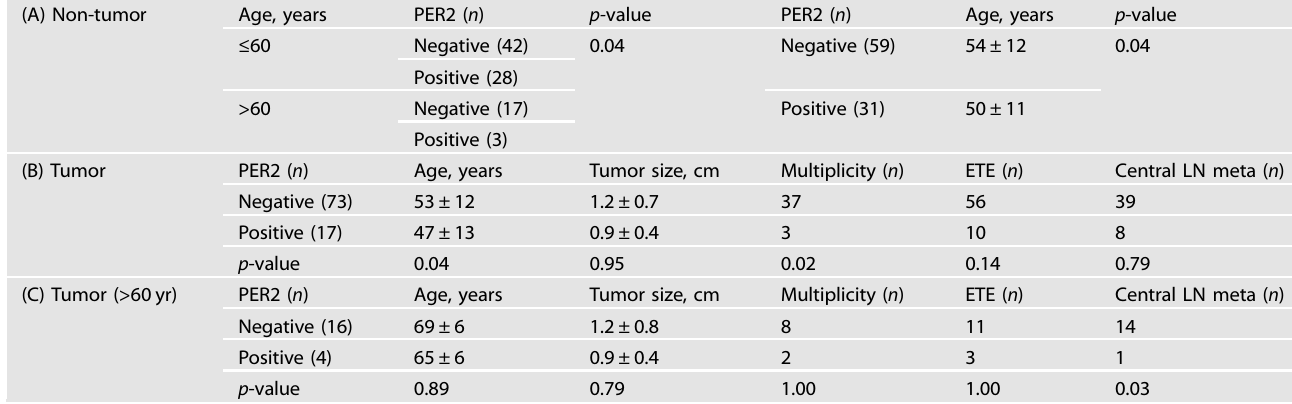
Table 2. Relationship between PER2 levels and aging in human thyroid gland samples (A); relationship between PER2 levels and pathological parameters in 90 PTCs (B); relationship between PER2 levels and pathological parameters in 20 PTCs from patients older than 60 years